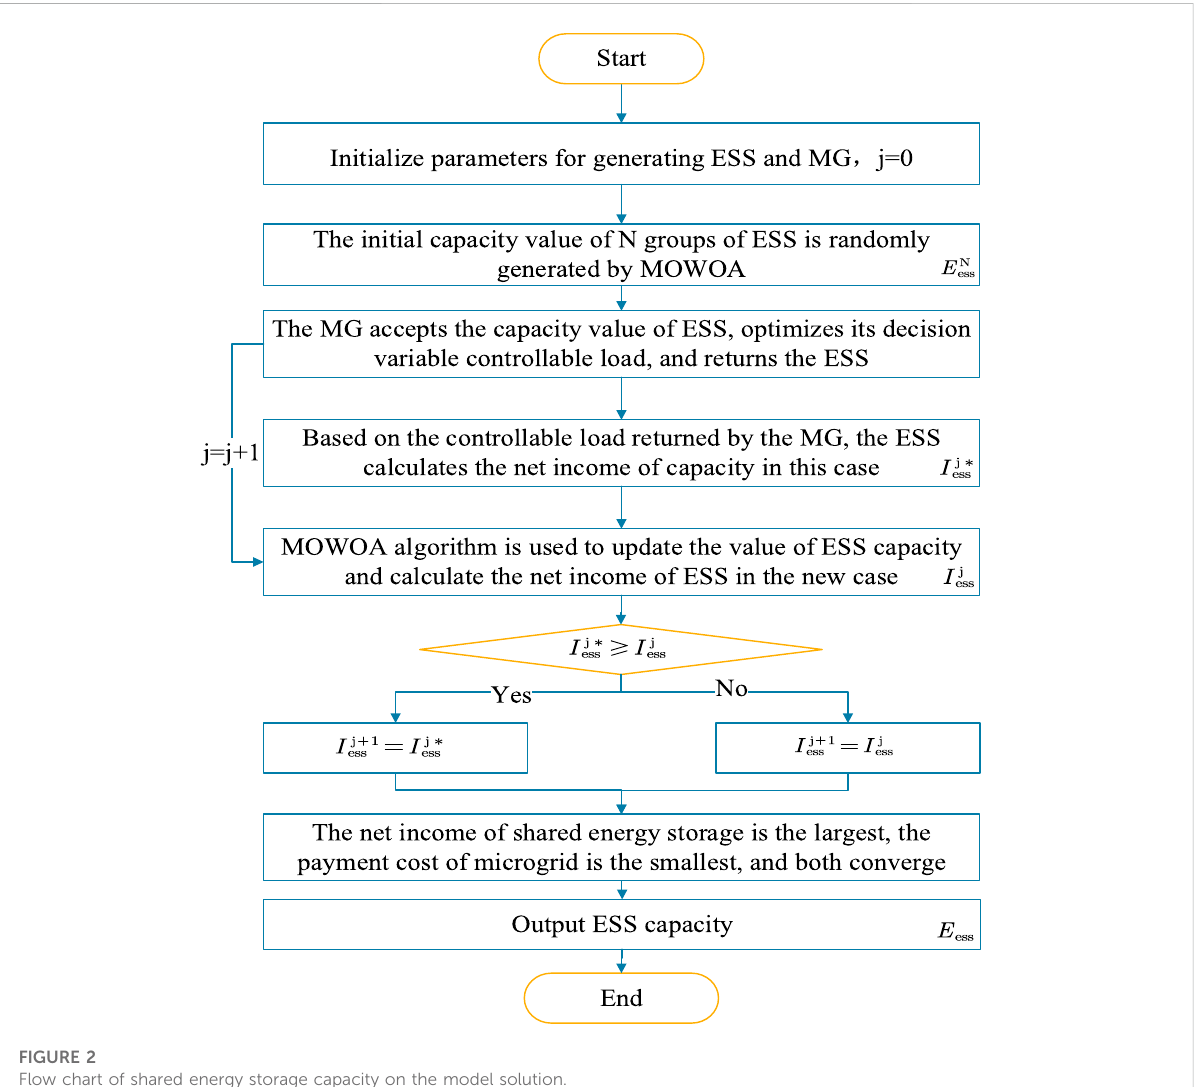
FIGURE 2 Flow chart of shared energy storage capacity on the model